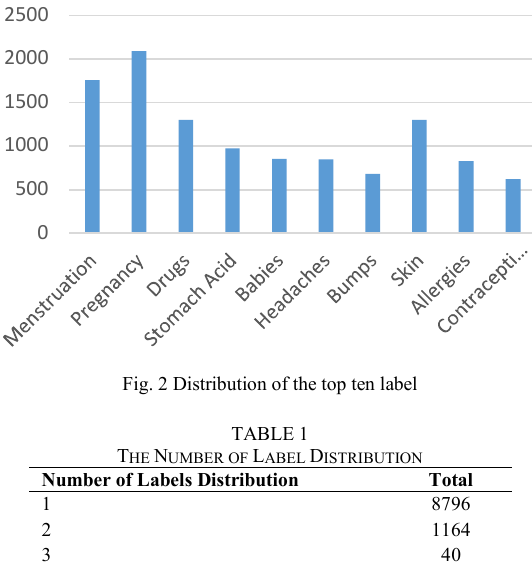
Fig. 2 Distribution of the top ten label TABLE 1 T HE N UMBER OF L ABEL D ISTRIBUTION